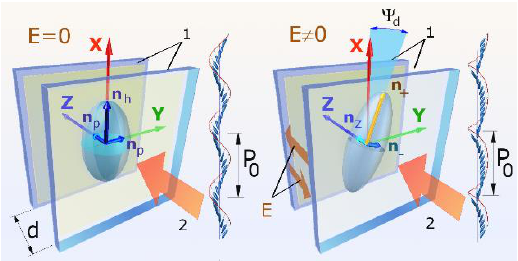
Figure 2. Geometry of a planar oriented deformed helix ferroelectric liquid crystal (DHFLC) cell with a uniform lying helix: Number 1 designates glass plates coated with continuous indium tin oxide (ITO) layers, over which the aligning layers are deposited; Arrow 2 shows the direction of propagation of linearly polarized incident light; d is the DHFLC layer thickness; p 0 is the helix pitch, n p and n h are refractive indices of the DHFLC helical structure at E = 0 [10]; and Ψ d (E) ~ E is the deflection of the main optical axis in the electric field.